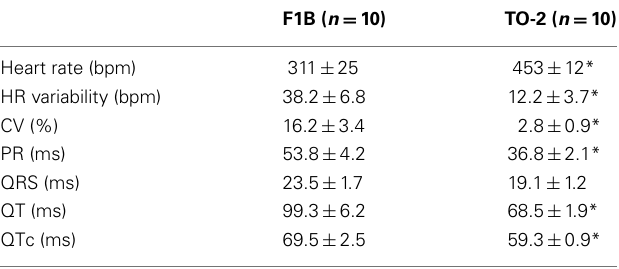
Table 1 | Electrocardiographic parameters in BIO F1B and BIOTO-2 conscious hamsters.